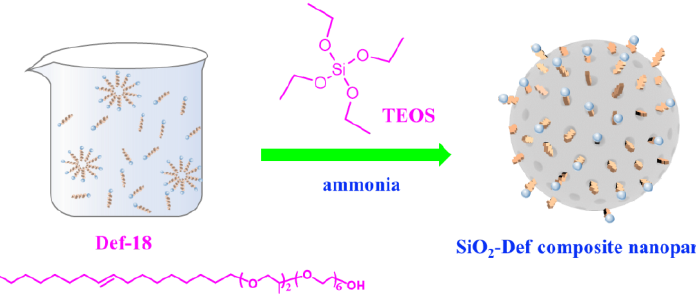
Figure 2. The preparation procedure of SiO 2 -Def nanoparticles.